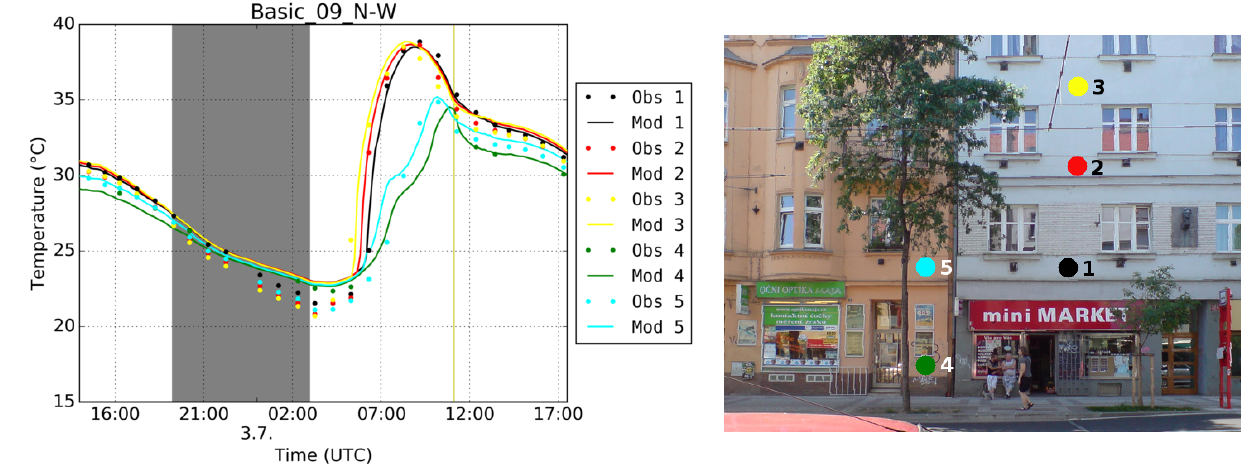
Figure 12. As for Fig. 9 for location 9 (50.10354 ◦ N, 14.45006 ◦ E) – view of the east-facing